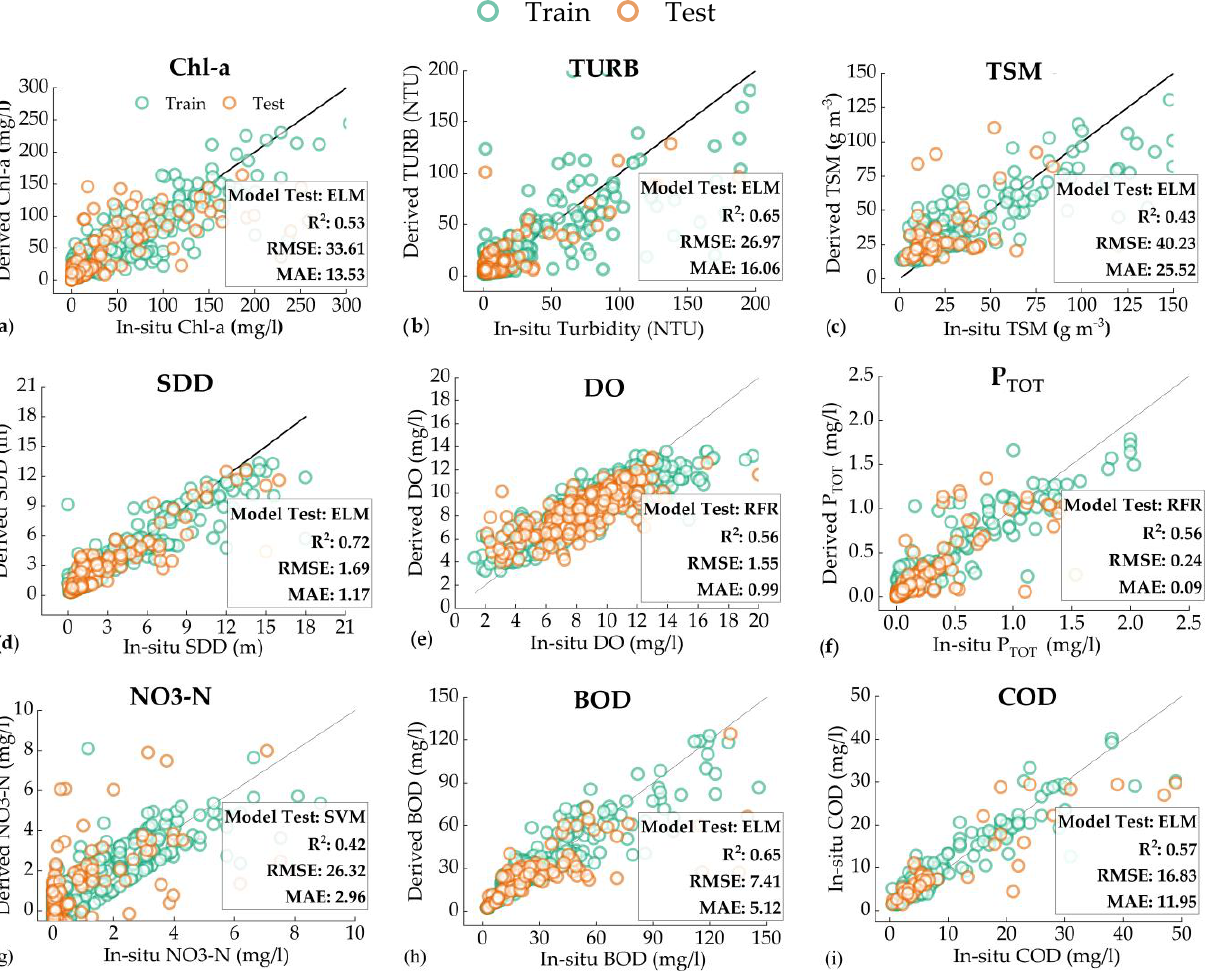
Figure 5. Scatterplots of modeled and measured water quality parameters in the test dataset.